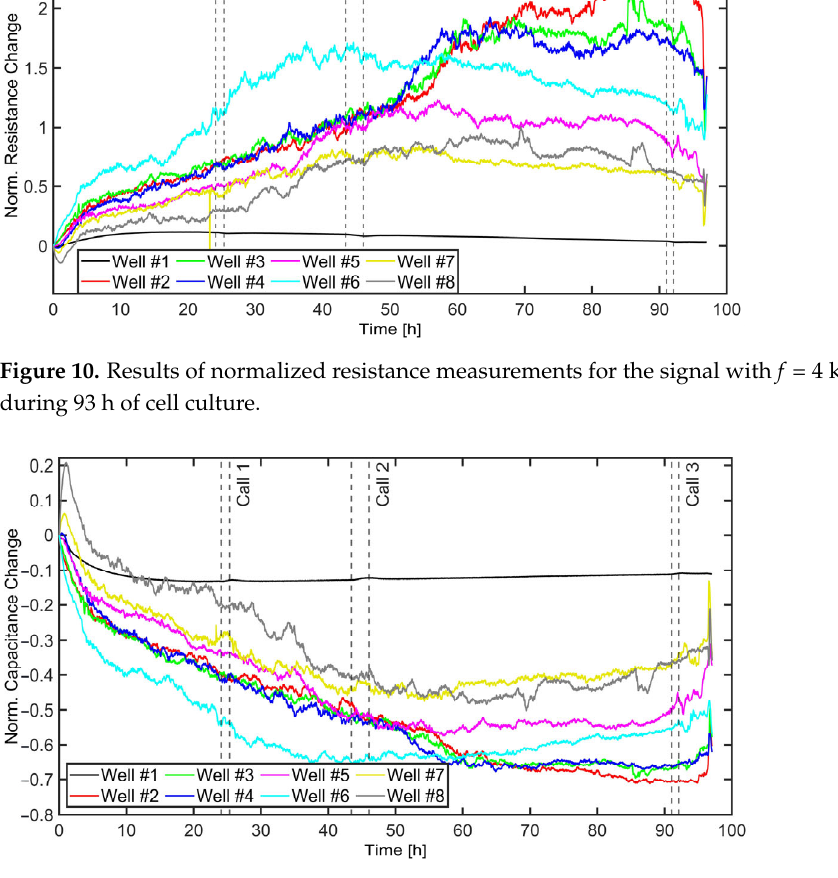
Figure 11. Results of normalized capacitance measurements for the signal with f = 64 kHz, measured during 93 h of cell culture duration.